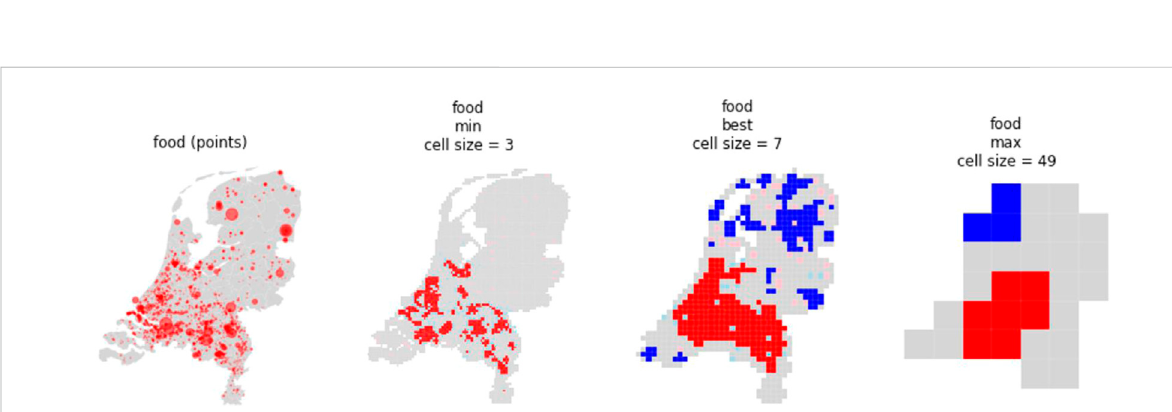
FIGURE 16 Comparing hot spot mapping with minimum, best fi t, and maximum cell sizes. Maps created by